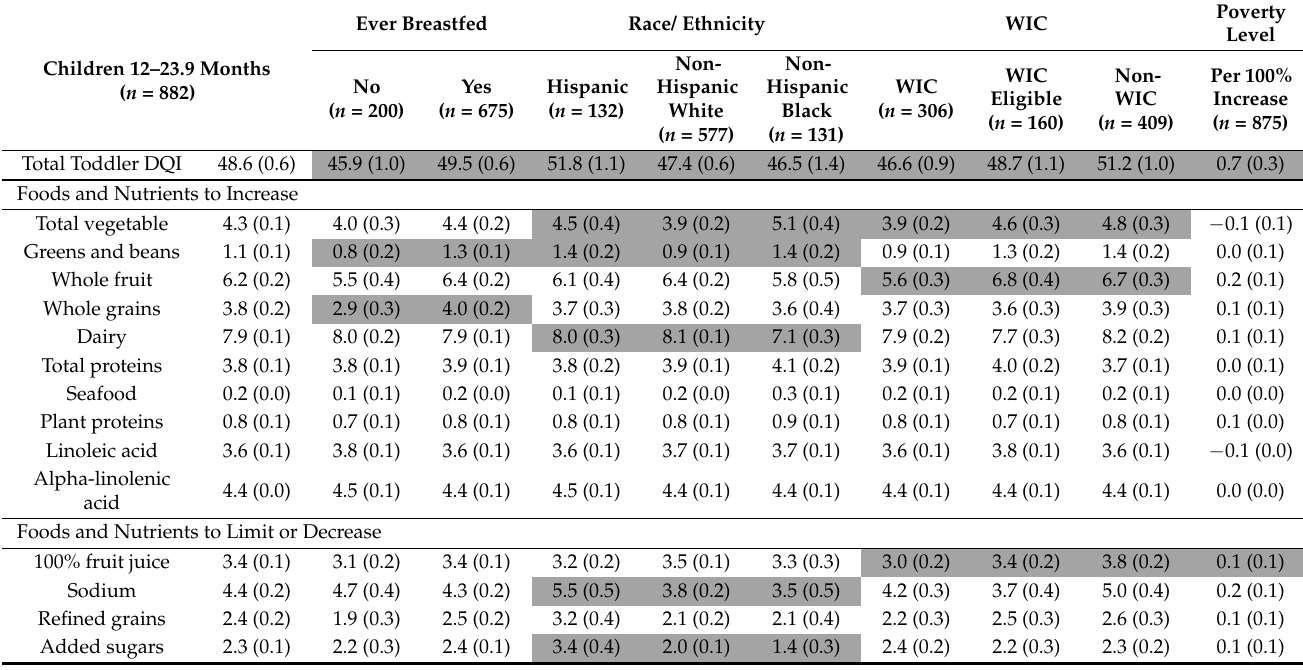
1 Adjusted for ever breastfed, WIC participation status, race and ethnicity, federal poverty level, households with one adult and living in urban settings; data not shown for households with one adult and living in urban settings. Shaded results indicate significant difference for the group, p < 0.05.